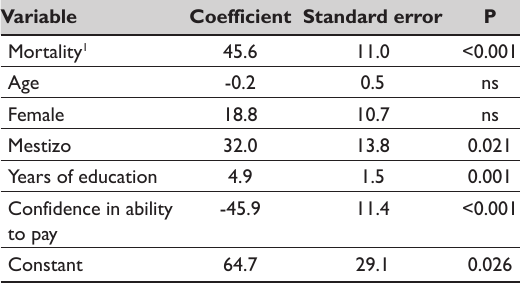
Table 2: Interval Regression Results of WTP